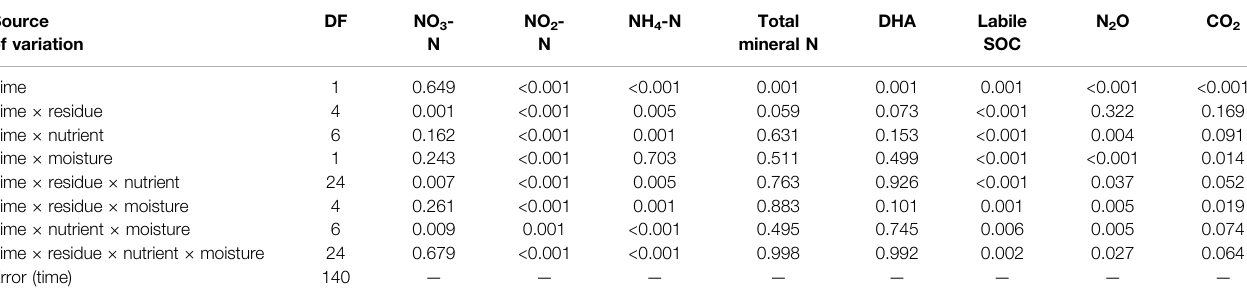
TABLE 3| Resultsof p valuebasedonrepeated measuresANOVAfornitrateN,NitriteN,ammonicalN,totalmineralN,dehydrogenaseactivity (DHA),andlabileSOC,CO 2 , and N 2 O emission during the incubation period. Source of variation